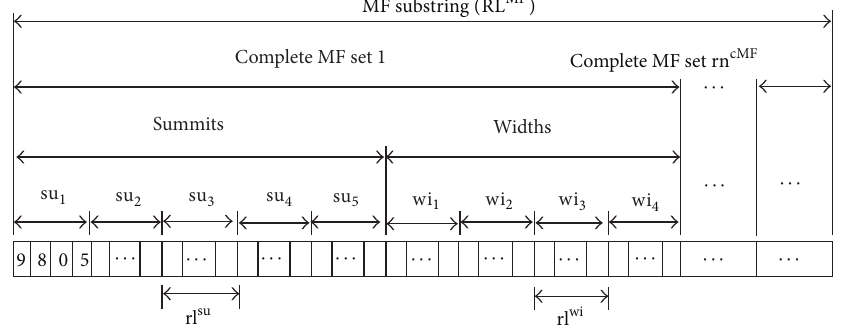
Figure 4: Summit and Width Representation Method